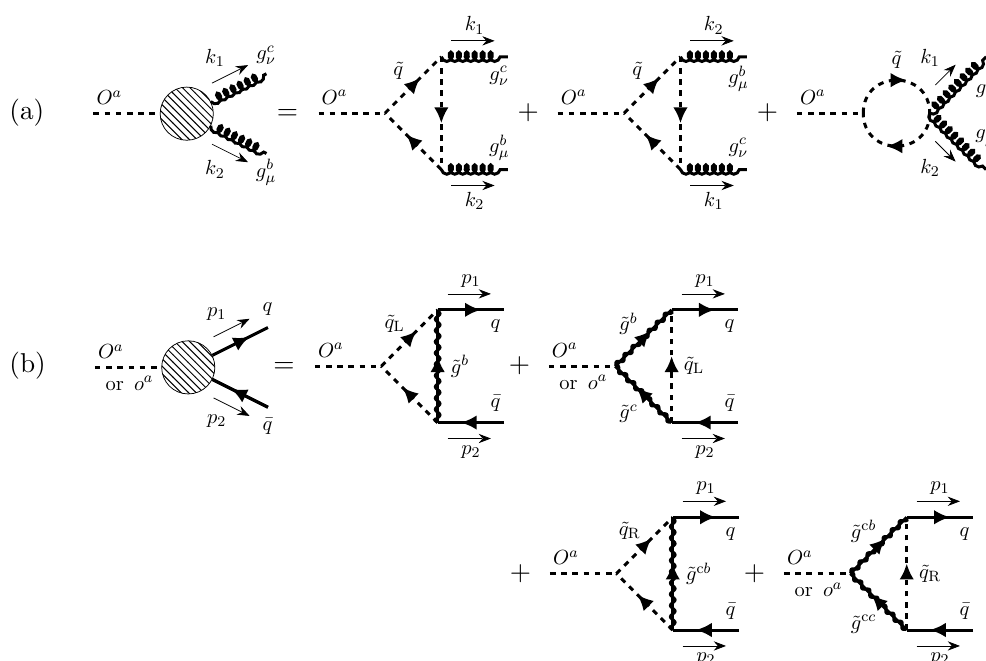
Figure 2. Diagrams for (a) scalar sgluon decays to gluons and (b) scalar or pseudoscalar decays to quark-antiquark pairs. Either ~ q L or ~ q R can run in the O ! gg loops. ~ q R run with charge-conjugated gluinos ~ g c in the O or o ! (cid:22) qq loops. Not all diagrams contribute to the pseudoscalar decay.